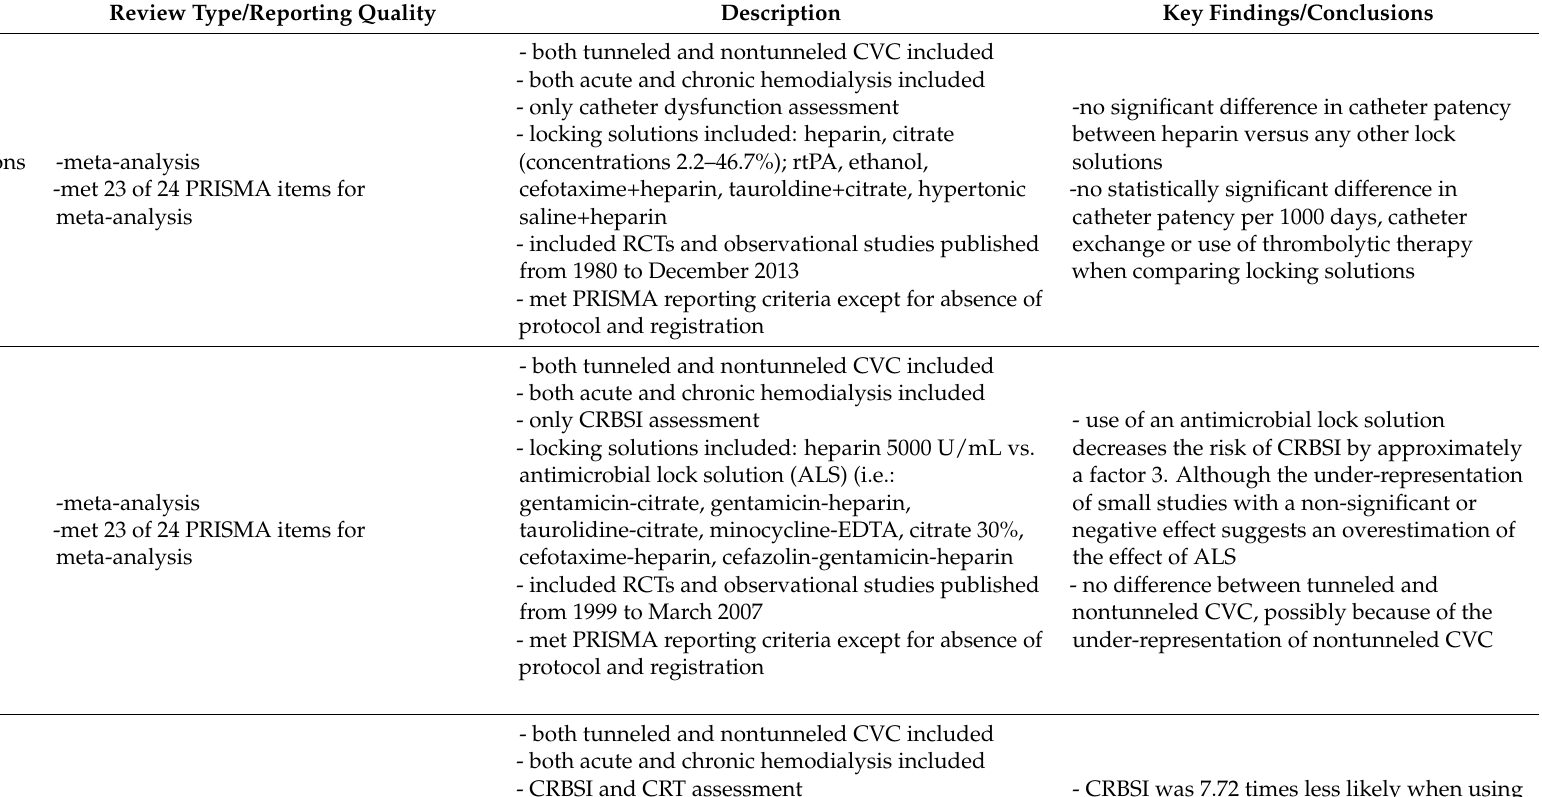
Table 1. Summary of key systematic reviews and